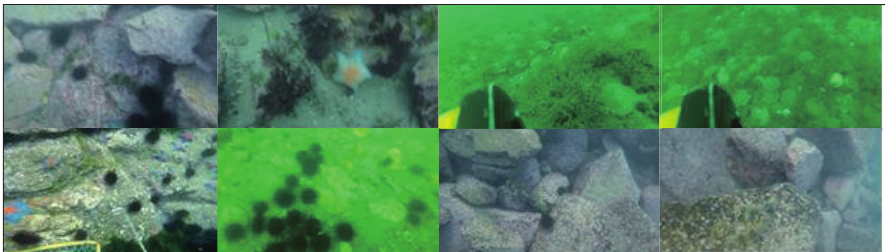
Figure 5. Dataset images of marine life (holothurian, echinus, scallops and starfish). It can be seen that, unlike normal images, underwater images have chromatic aberration and low contrast, resulting in poor image quality.